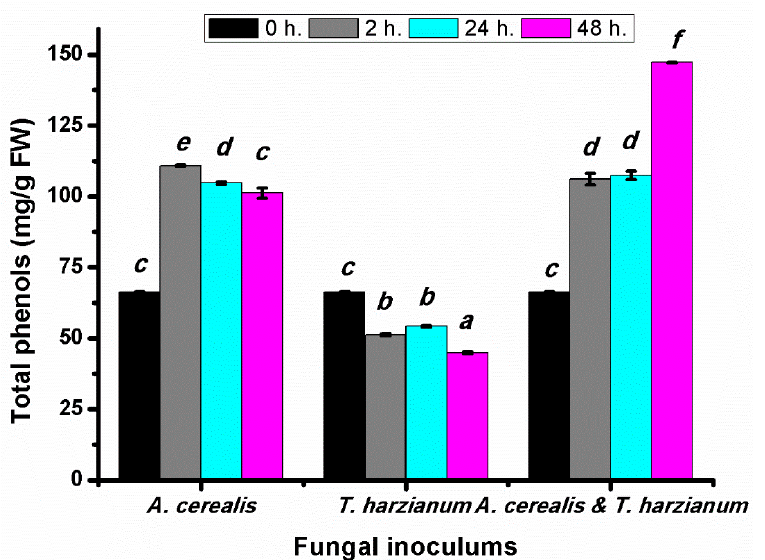
Figure 6. Total phenols (mg/g FW) of tomato leaves ( S. lycopersicum L.) under the effect of pathogen ( Alternaria cerealis MT808477), and pathogen inhibitor ( Trichoderma harizainum ) after 0, 2, 24, 48 h of inoculation, data are means ± SD ( n = 3), with statistically significant differences ( p < 2.5. Effect of Infection Period on the Total Flavonoid Production of Tomato Leaves during the